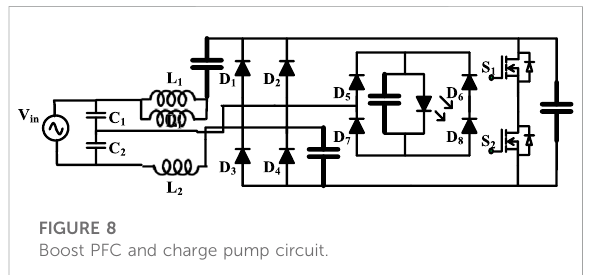
FIGURE 8 Boost PFC and charge pump